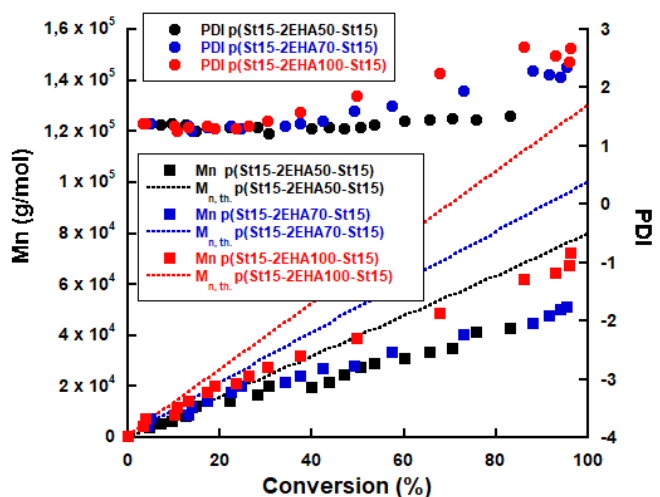
Figure 4. Evolution of the number average molecular weight and polydispersity index vs monomer conversion for di ff erent p(St-EHA-St) compositions.